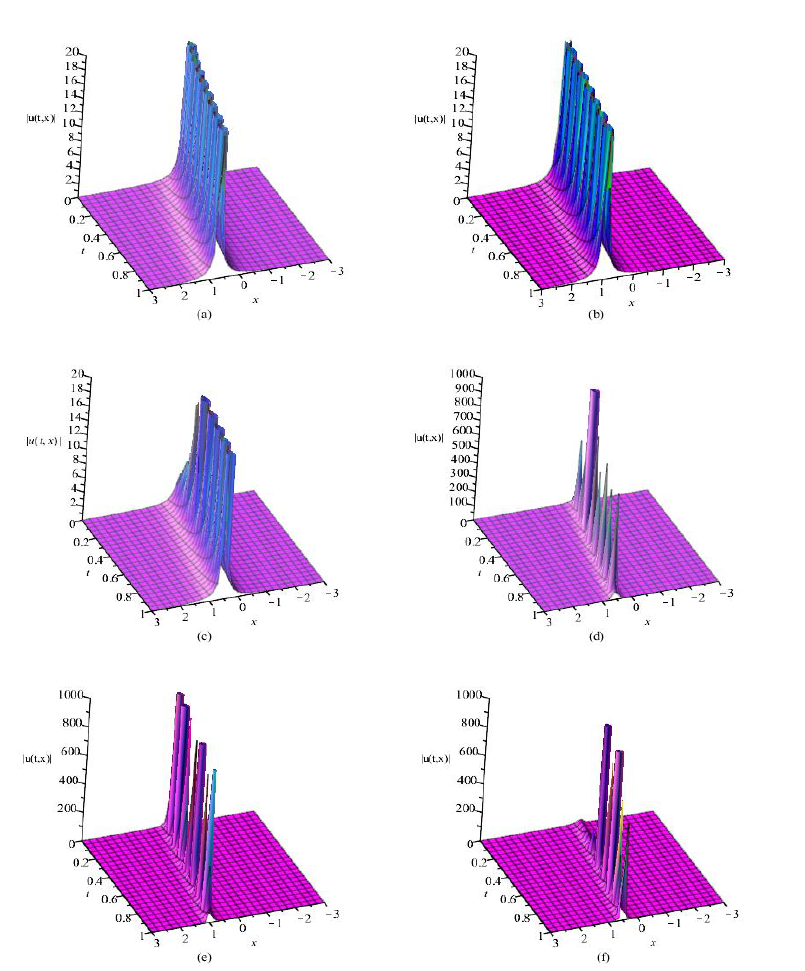
Figure 9. Exact solutions with k 1 = α 1 = a = c = 2, λ 3 = 1, and ( a ) n = 0.5, m = 2, α = 0.8, β = 0.9, w.r.t. M-derivative (34), ( b ) n = 0.5, m = 2, β = 0.9, w.r.t. beta-derivative (35), ( c ) n = 0.5, m = 2, α = 0.8, w.r.t. hyperbolic-derivative (36), ( d ) n = 1.5, m = 3, α = β = 0.9,